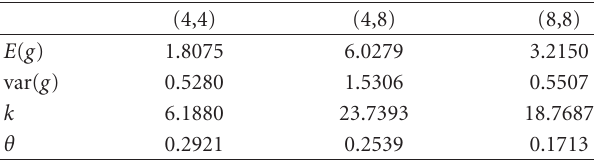
Table 1: Parameters for Gamma approximation for some selected MIMO